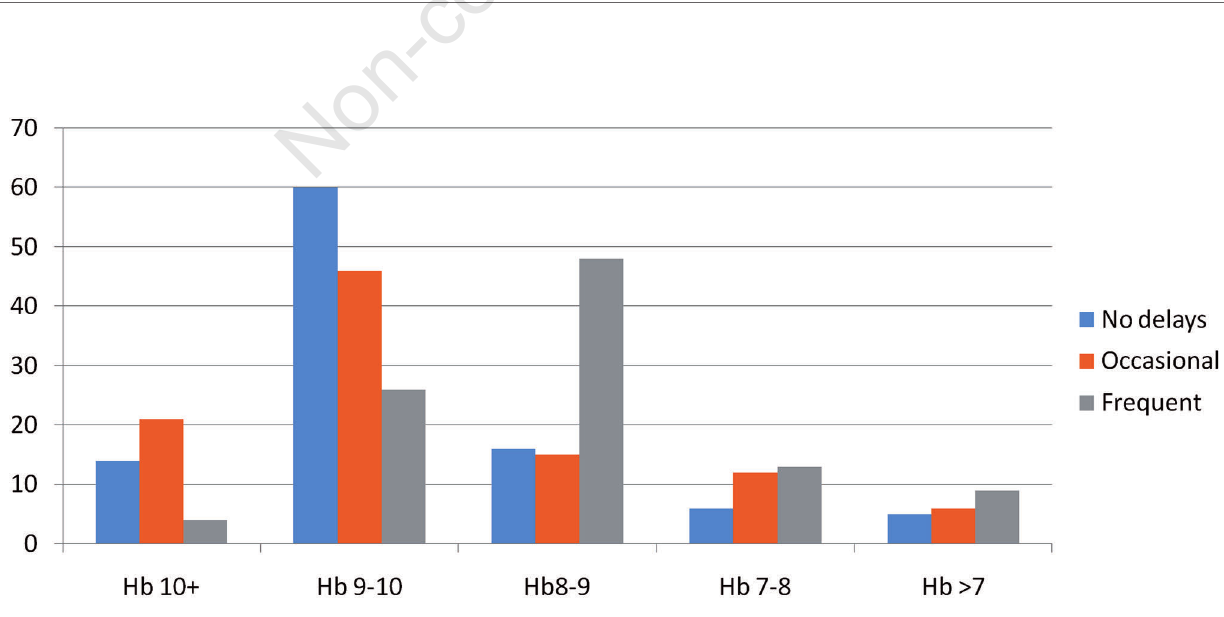
Figure 1. Pre-transfusion haemoglobin levels according to country HDI level.